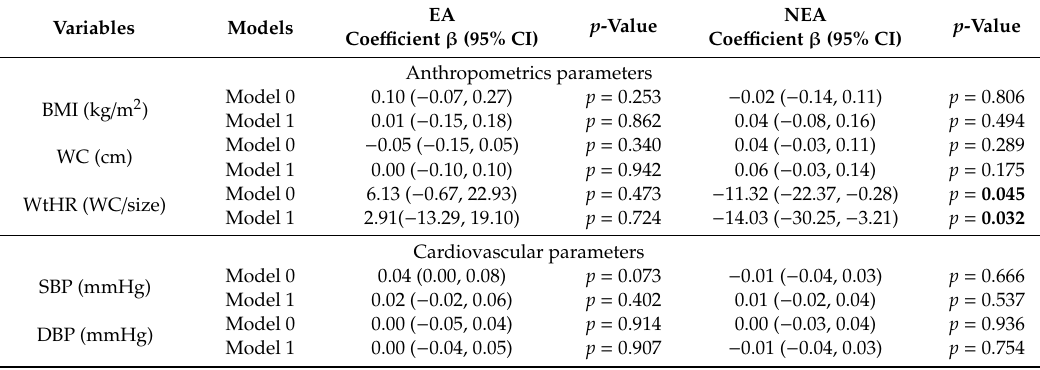
Table 3. Association between health-related to quality of life (HRQoL) and anthropometrics, cardiovascular, fitness and lifestyle